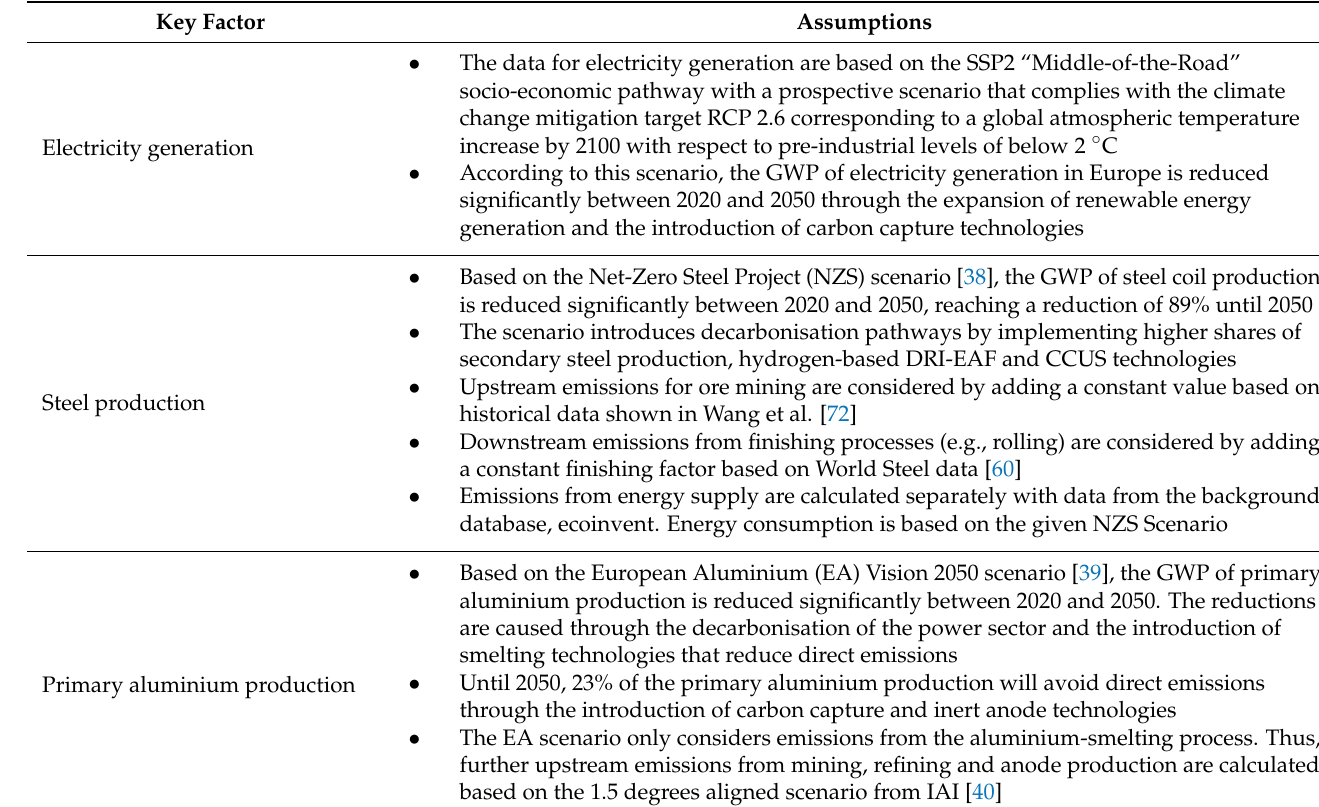
Table A2. Assumptions for the scenario development of the background